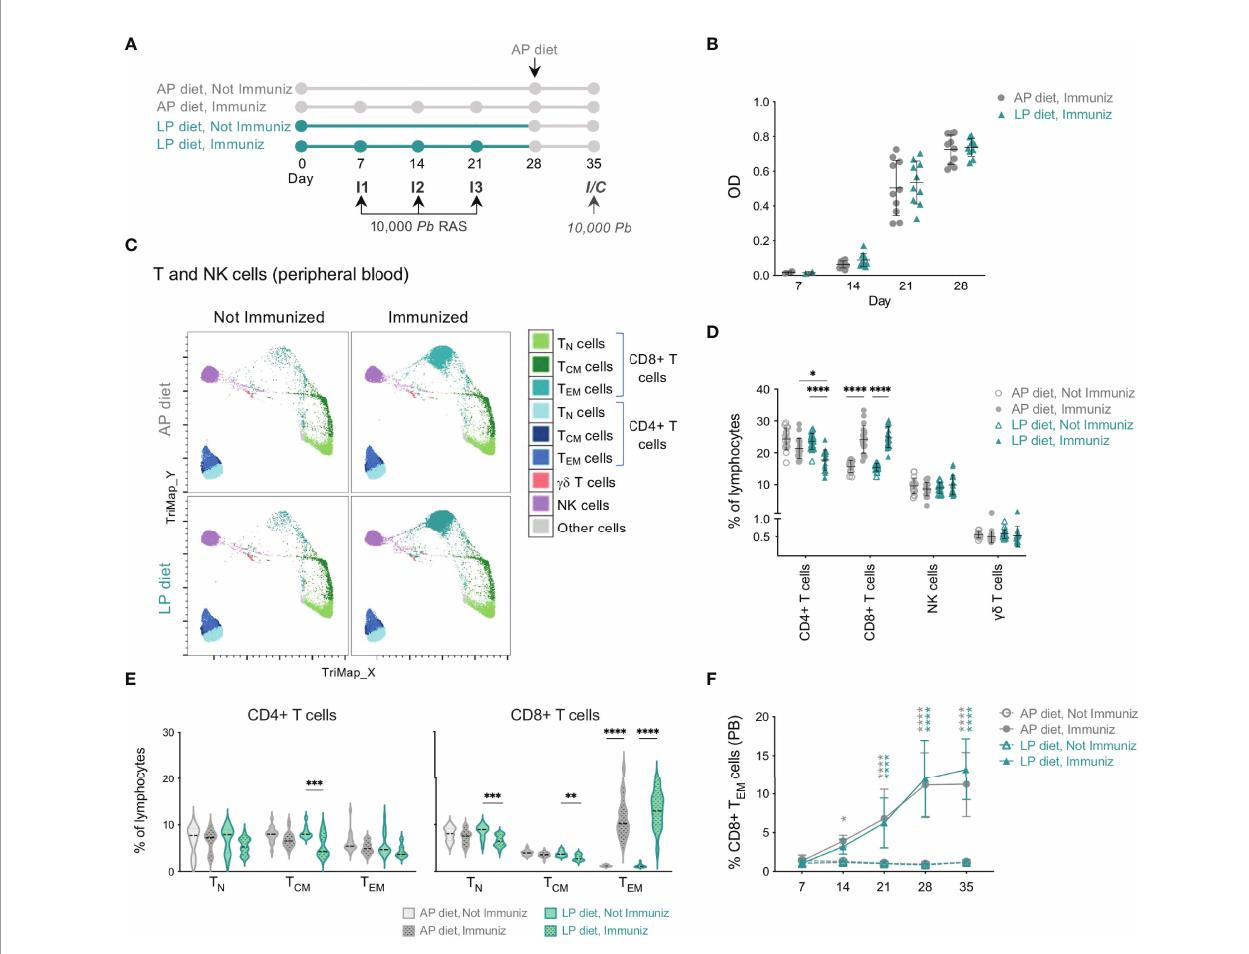
FIGURE 2 | Impact of low protein diet during RAS immunization on the circulating immune response. (A) Protocol used in the study. The immunization schedule consisted of 3 immunizations (I1, I2, I3) with 10,000 Pb RAS under adequate (AP; 20%) or low (LP; 9%) protein diet, followed by one week under AP diet. Non- immunized and immunized mice were subsequently infected/challenged (I/C) on day 35. (B) Levels of anti- Pb sporozoite IgG in the plasma of mice immunized under AP or LP diet. (C) TriMap dimensionality reduction analysis of circulating immune populations (day 35) in concatenated data of non-immunized or RAS-immunized mice maintained under AP or LP diets, based on the following markers: CD3, CD4, CD8, CD44, CD62L, TCR gd and NK1.1. (D) Frequency of CD4+, CD8+, gd T and NK cells in the peripheral blood of non-immunized or RAS-immunized mice under AP or LP diet on the day of the infection/challenge (day 35). Each symbol represents a mouse (n = 15 to 20 per group). (E) Frequency of T CD4+ and CD8+ naïve (T N ), central memory (T CM ) or effector/effector memory (T EM ) populations in mice under each condition on day 35 (n = 13-20). (F) Frequency of CD8+ T EM in the peripheral blood (PB) of mice under each condition (n = 11-20 per group). The symbols represent statistically signi fi cant differences between non-immunized and RAS-immunized mice within AP (in grey) or LP (in blue) diet. Data are presented as mean ± SD and were compared using the Mann-Whitney test (two-sample data) or the Kruskal-Wallis test with Dunn ’ s multiple comparison post-test with selection of the following pairs: AP diet Not Immunized (NImm) vs. AP diet Immuniz (Imm), LP diet NImm vs. LP diet Imm, AP diet NImm vs. LP diet NImm and AP diet Imm vs. LP diet Imm (*P < 0,05; **P < 0,01; ***P < 0,001; ****P <